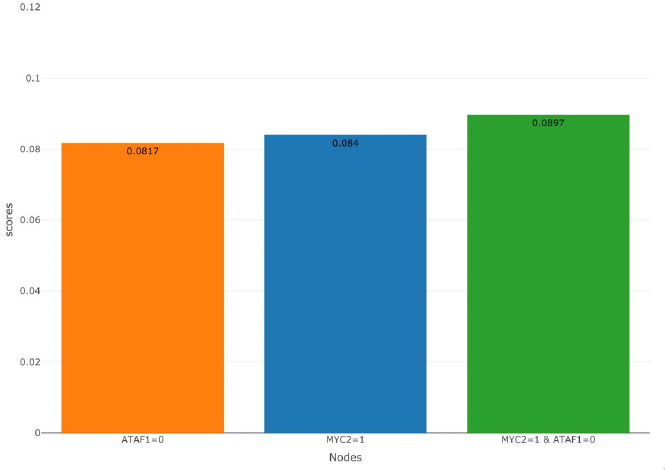
Fig 7. Comparing the scores of multi-node and single node intervention under optimal response case. Simultaneous (multi-node) intervention on MYC2 and ATAF1 has a slightly higher score than single node